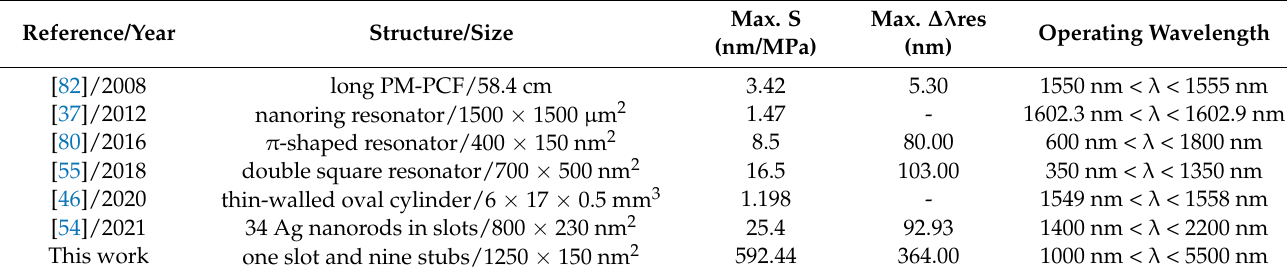
Table 4. Comparison of the designed plasmonic pressure sensor with the published